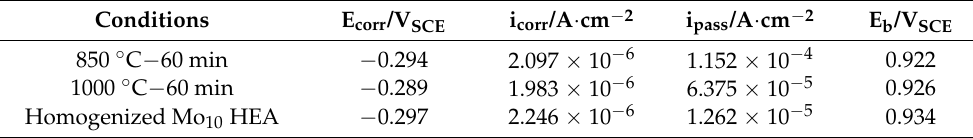
Figure 8. The corrosion morphology of the Mo 10 HEA in the 0.5 M H 2 SO 4 solution: ( a ) 850 °C − an- nealed sample; ( b ) 1000 °C − annealed sample; ( c ) the homogenized Mo 10 sample. Table 3. The electrochemical testing results obtained from Figure 7a. Conditions E corr /V SCE